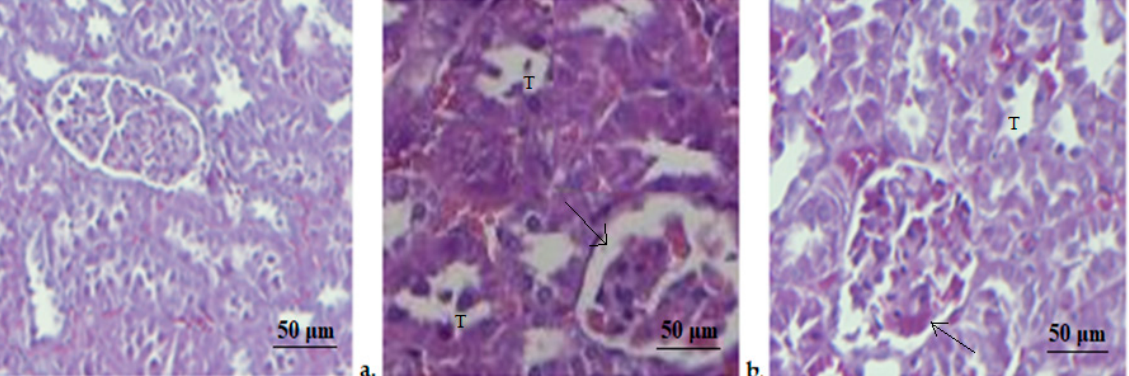
Figure 5. Kidney histopathologic exam. ( a ) Control group; ( b ) STZ group; ( c ) STZ+Zn group. (arrow—infiltration of mononuclear cells, T—tubular epithelium). Masson trichrome stain × 20.